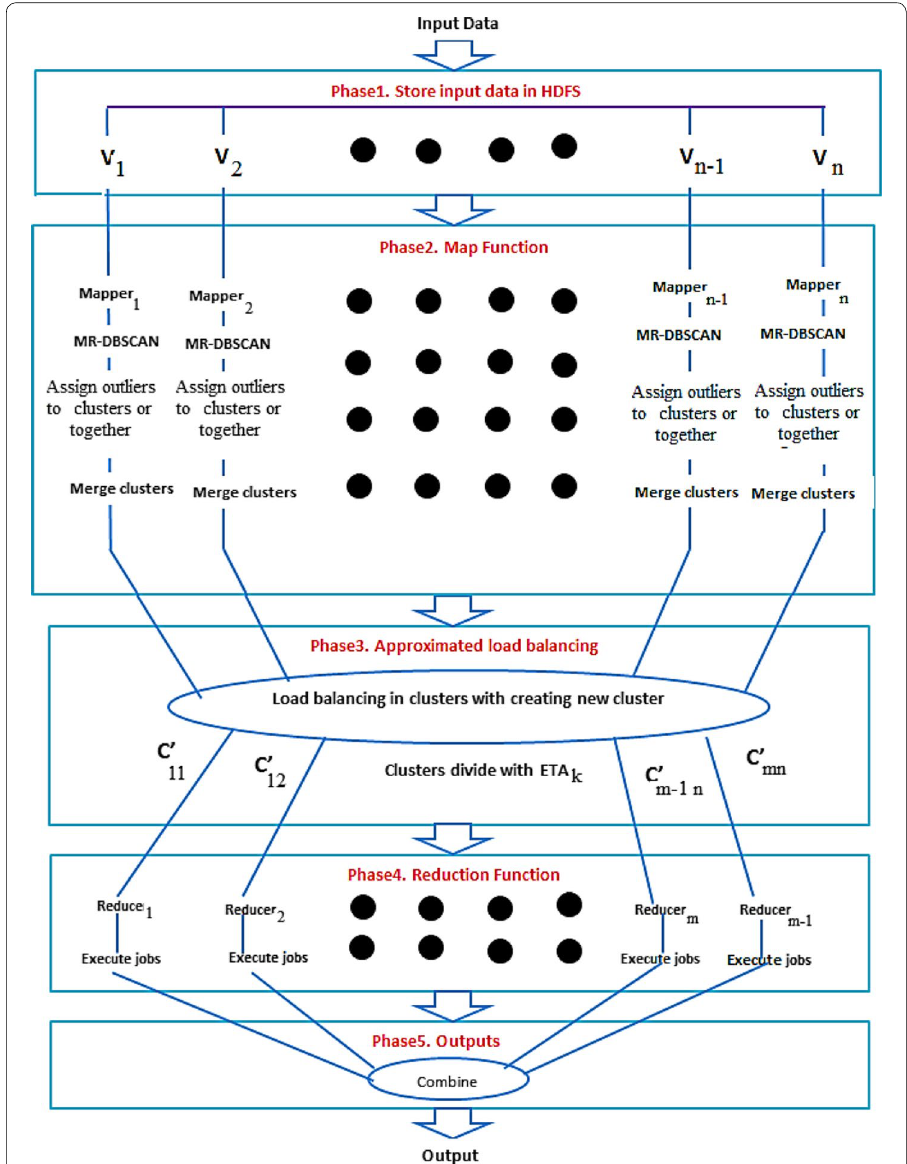
Fig. 1 Block diagram of proposed method